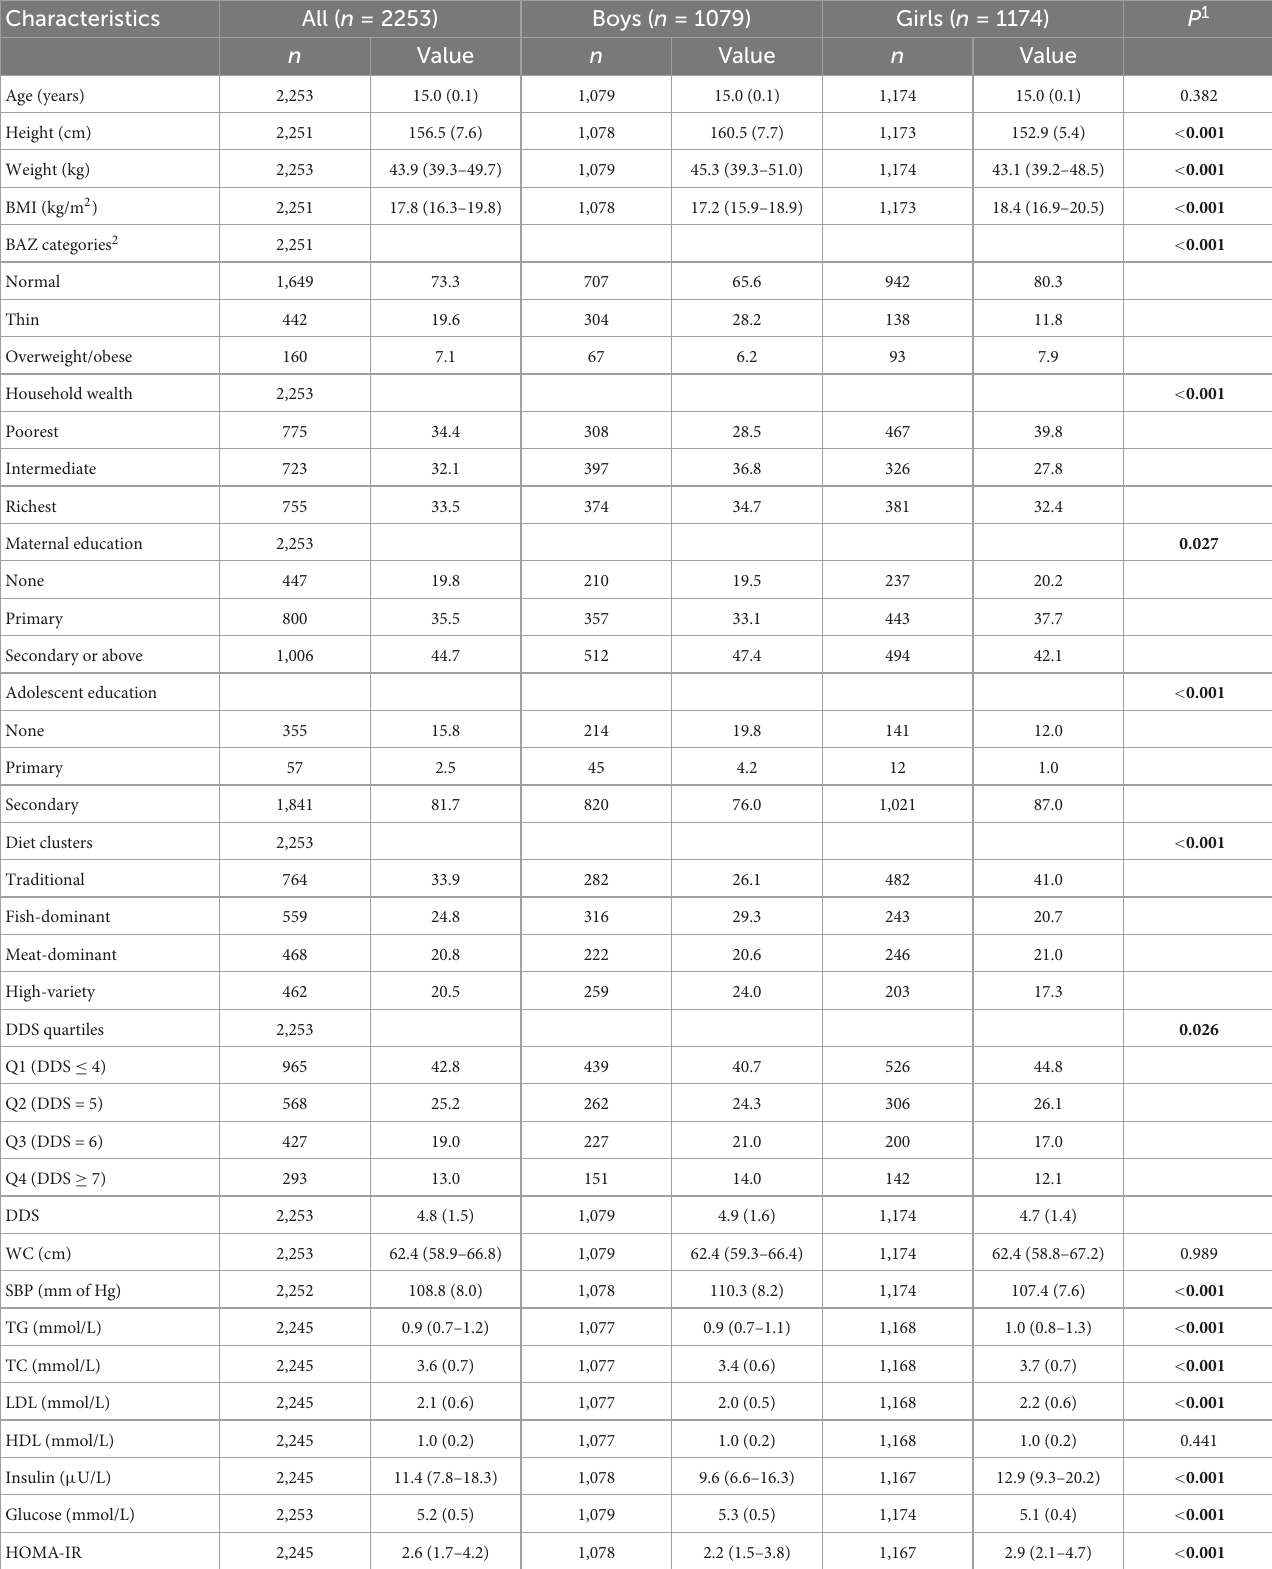
TABLE 2 Descriptive characteristics of the adolescents participating in the study.